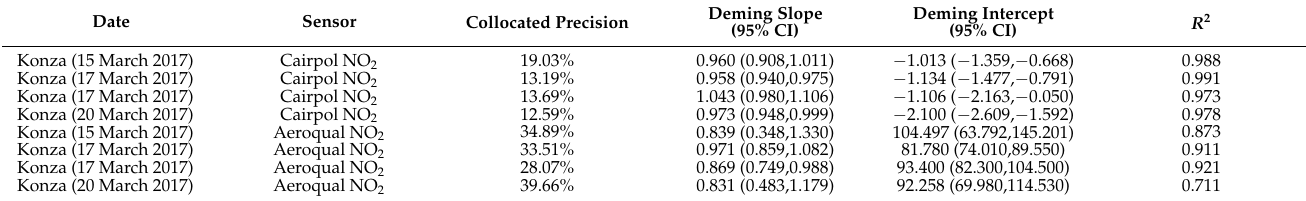
Table 5. Collocated precision, Deming regression statistics, and r 2 values for duplicate NO 2 sensors during the field